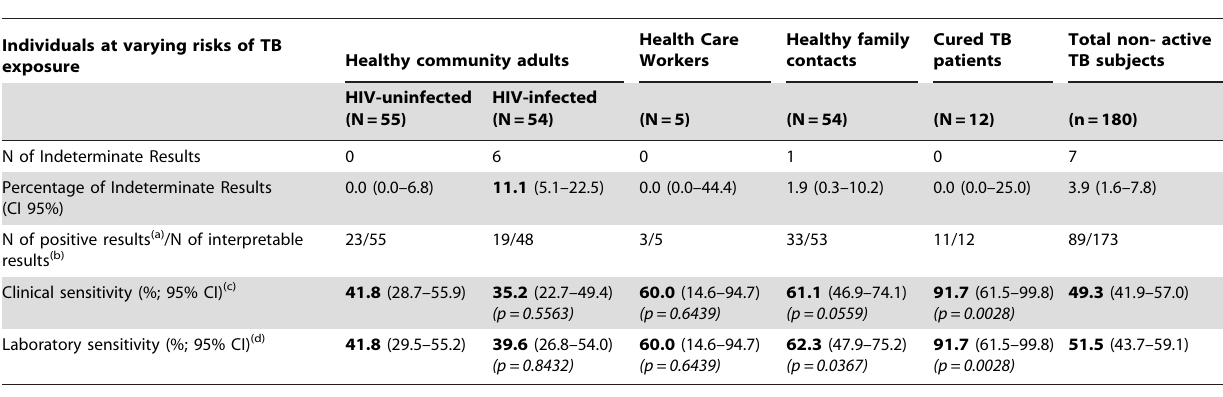
Table 3. Number and percentage (95% CI) of indeterminate results, number of positive and interpretable results and sensitivity rates (percentage; 95% CI) of QuantiFERON H Gold in Tube (QFT-GIT) in groups of individuals without active TB at varying risks of M. tuberculosis exposure.